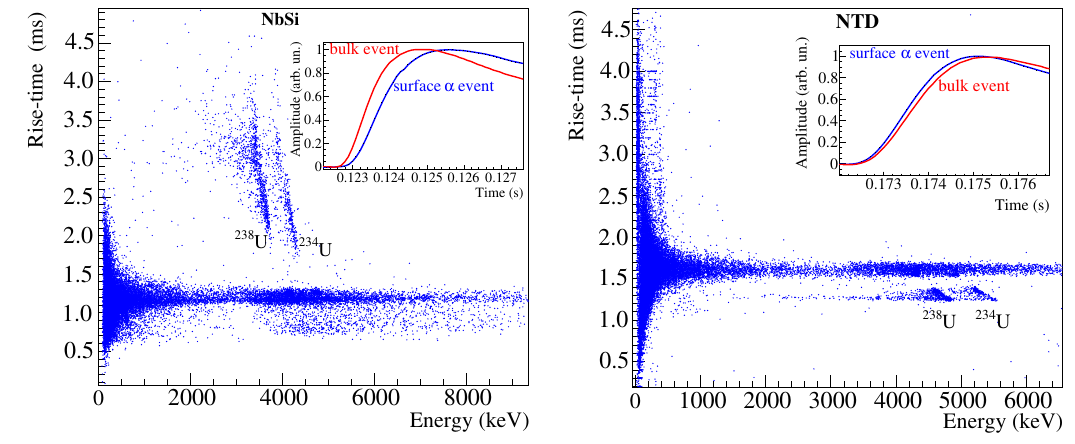
Figure 13 . The same set of events acquired by Detector 4 of table 1 represented with rise-time vs. pulse-amplitude plots for NbSi-(cid:12)lm signals (left panel) and NTD-Ge-thermistor signals (right panel). The inverted behaviour of the two sensors in terms of rise-time of surface events is apparent. As for the energy of the (cid:11) events, see caption of (cid:12)gure 4. In the insets, a direct comparison of signal rise-times for bulk and surface events is shown, both for NbSi sensor (left panel) and NTD Ge thermistor (right